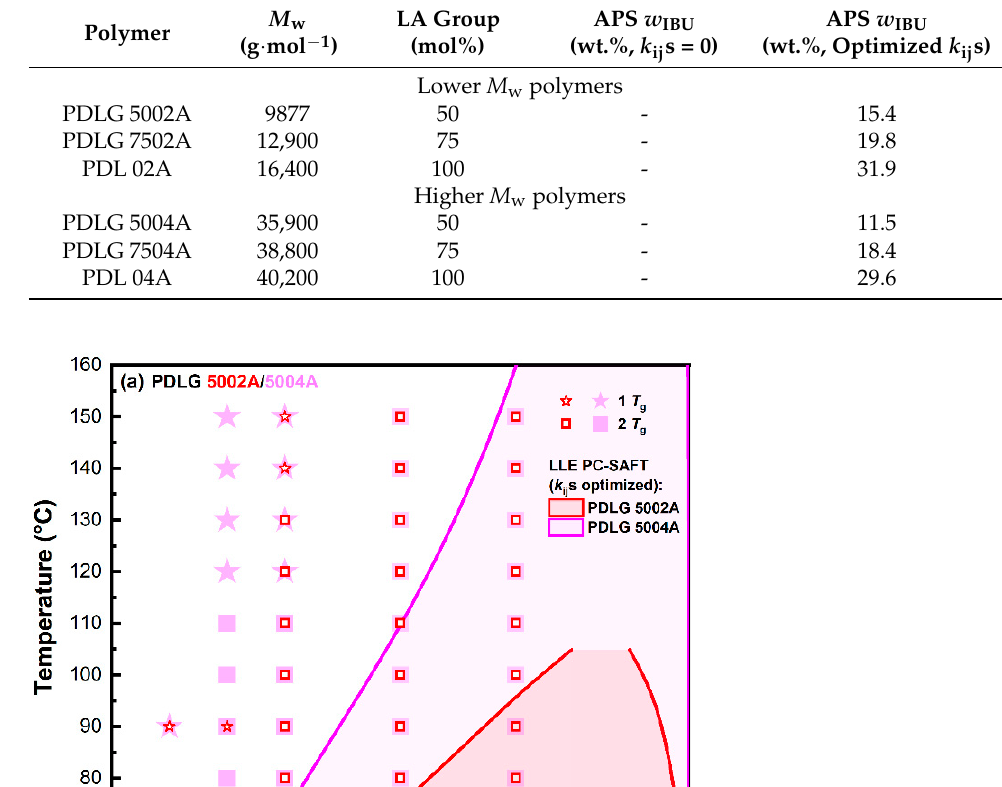
Table 5. Miscibility limit w IBU (wt.%, polymer-rich phase) at 25 ◦ C calculated using the PC-SAFT with k ij s = 0 and optimized k ij